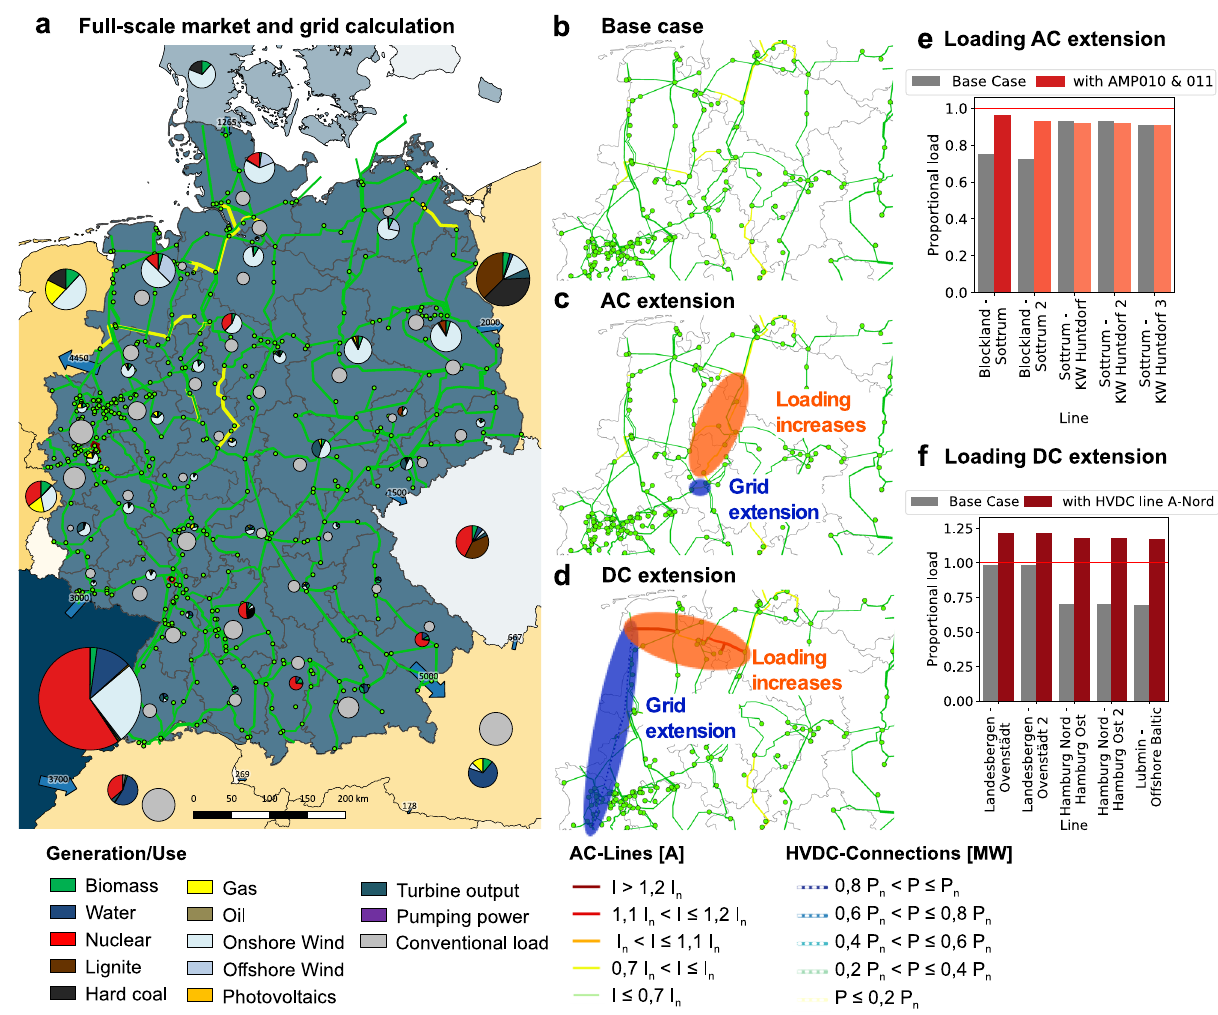
Fig. 4 | Expansion plans in real power grids cause non-local overloads of the grid. a A simulation of the German power grid is performed using a full-scale marketwherethecolorcodeshowsthecurrentrelativetothethermallimitcurrent: Yellowindicateshighloads,whileorangeorredindicatesanoverload,seeMethods for details on the simulation model. b Zoom on the North-western part of the German power grid in its base load case. c Including an AC expansion (blue oval) causes higher loadings (orange oval). The color code of the lines denotes the increaseinload.Somelinesarenowclosetotheiroverloadcondition. d Includinga